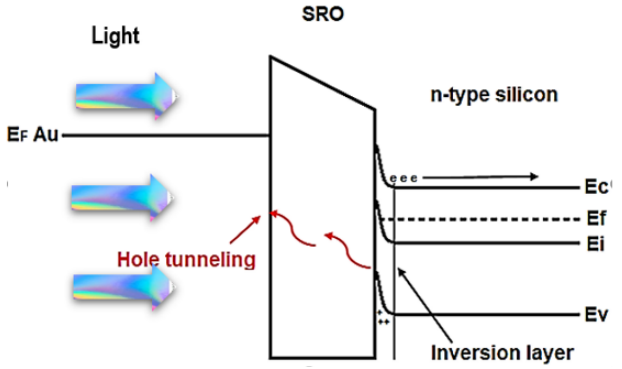
Figure 21. Schematic energy band diagram of Au/SRO/n-Si device under illumination.